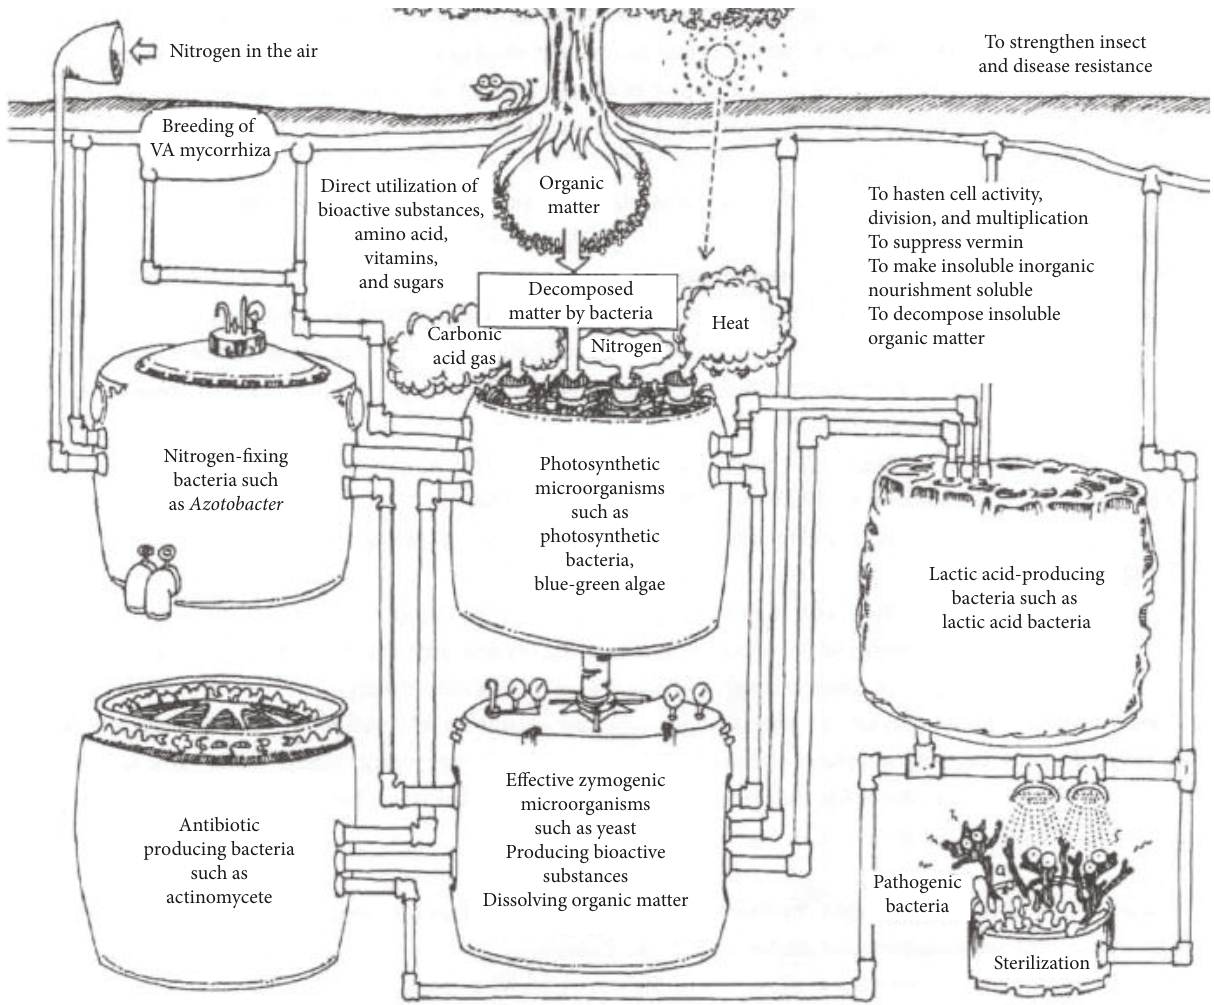
Figure 1: Functions of effective microorganisms in the soil in “Microorganisms for Agriculture and Environmental Preservation”, Higa [19], Nou-bun Kyo (in